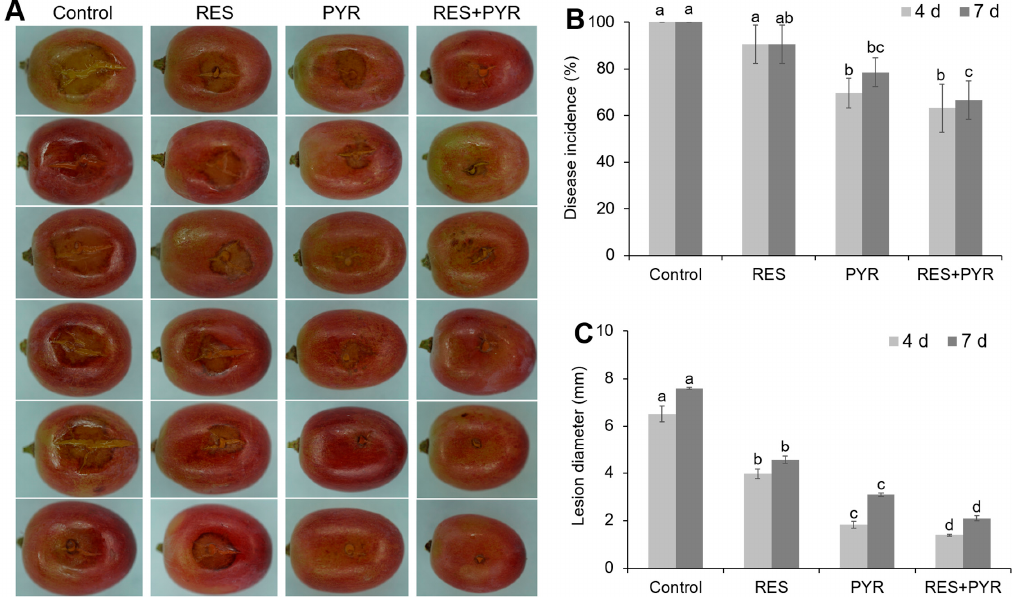
Figure 3. Control of table grape gray mold by resveratrol and pyrimethanil. Harvested grape berries were subject different drug treatment along with B. cinerea inoculation and kept at 22 °C. Symptoms were assessed and photographed at 7 days post inoculation ( A ). Disease incidence ( B ) and lesion diameter ( C ) were measured at 4 days and 7 days post inoculation, presented as bar charts. RES and PYR represent resveratrol and pyrimethanil treatment individually. RES+PYR represent resveratrol and pyrimethanil used in combination. Data was presented as mean± SE (standard error), and same set of columns followed by different letters indicate significant ( P < 0.05) differences according to Duncan’s multiple range test.